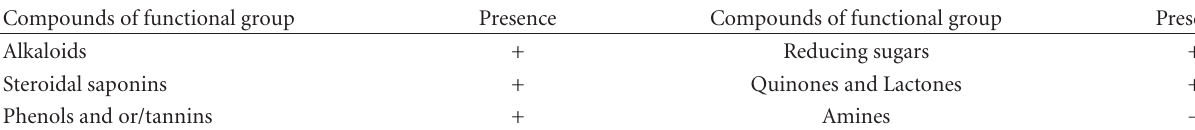
Table 7: Phytochemical screening of EEPD.